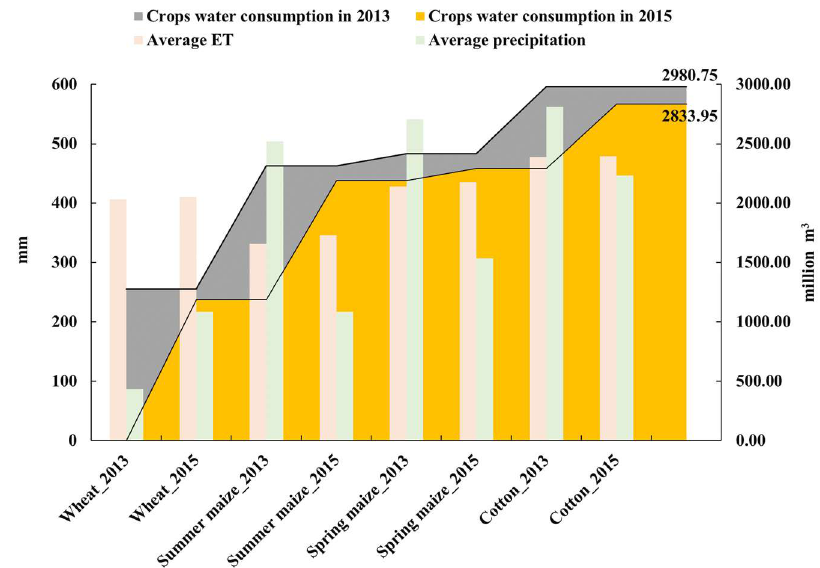
Figure 7. A comparison of average ETs, average amounts of precipitation and crops’ water consumptions in Hengshui. The histogram shows the average ET and average precipitation during the growth period for every crop. The gap between the two is the demand for crop irrigation. The area chart accumulates the total water consumption of the main crops in 2013 and 2015 in turn.